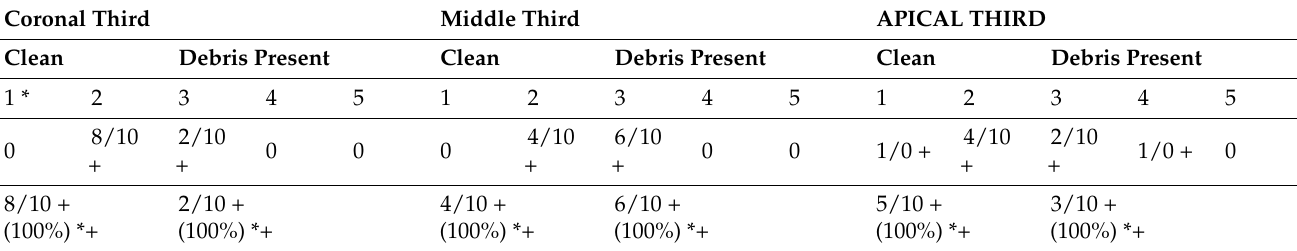
Table 14. Group 2: Debris score with 17% EDTA.